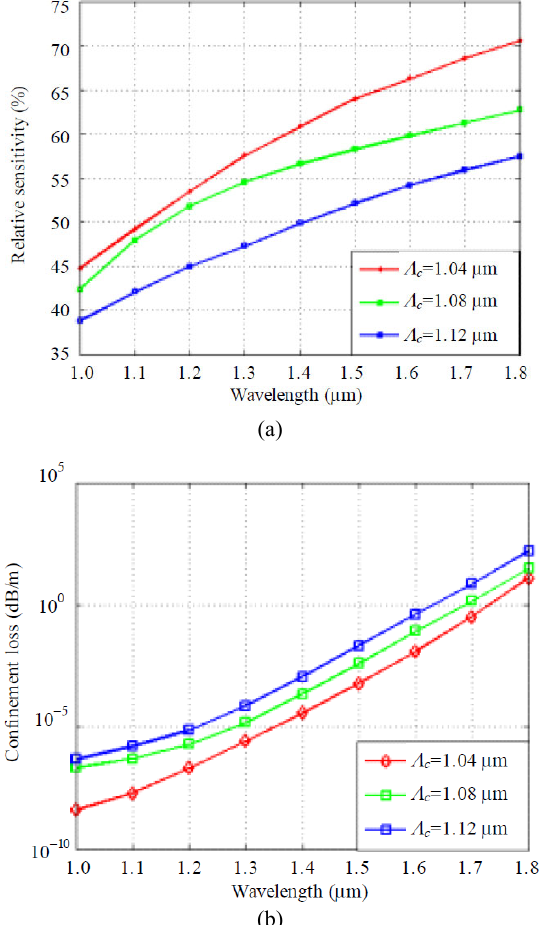
Fig. 7 Comparison between: (a) relative sensitivity versus wavelength and (b) confinement loss versus wavelength curve for the proposed H-PCF for optimized parameters:  = 3.00  m;  c = 1.04  m, 1.08  m, and 1.12  m; d = 2.85  m, d c = 0.774  m, and d c 0 = 1.08 